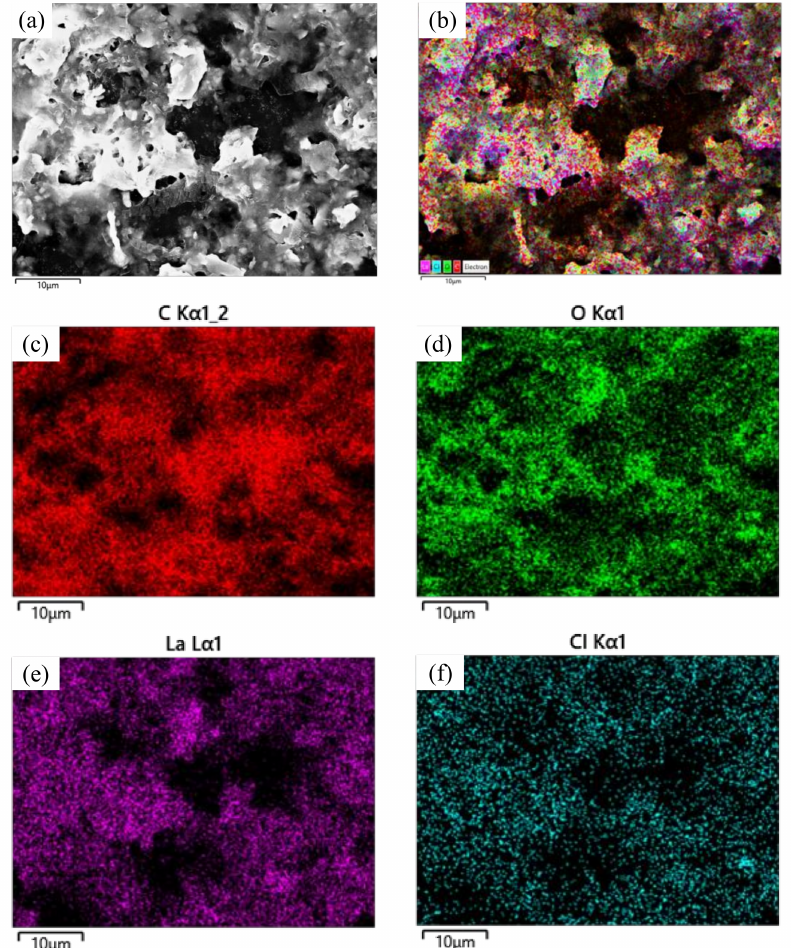
Figure 7. EDS plane scan images of lanthanum stearate. ( a ) lanthanum stearate; ( b ) Element distribution; ( c ) C; ( d ) O; ( e ) La; ( f )